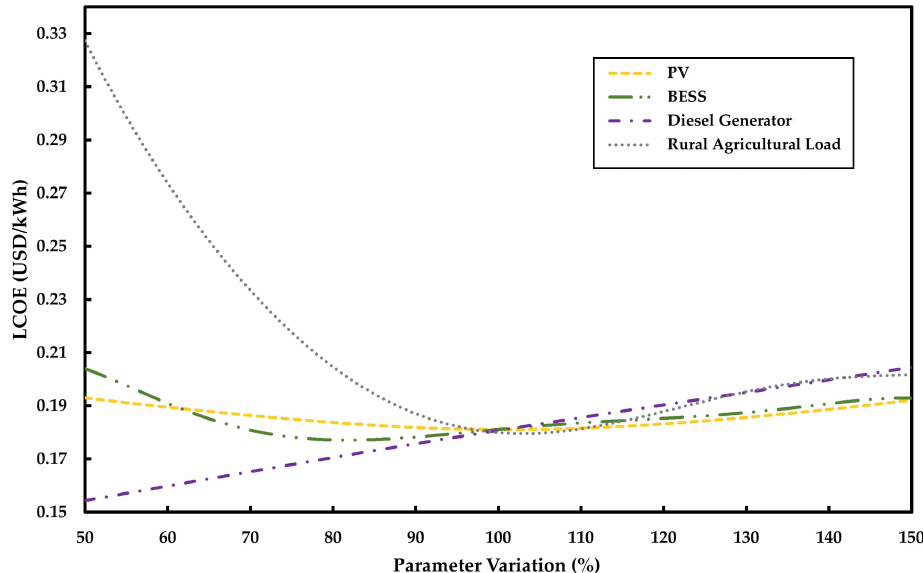
Figure 23. Sensitivity of LCOE to variation of different